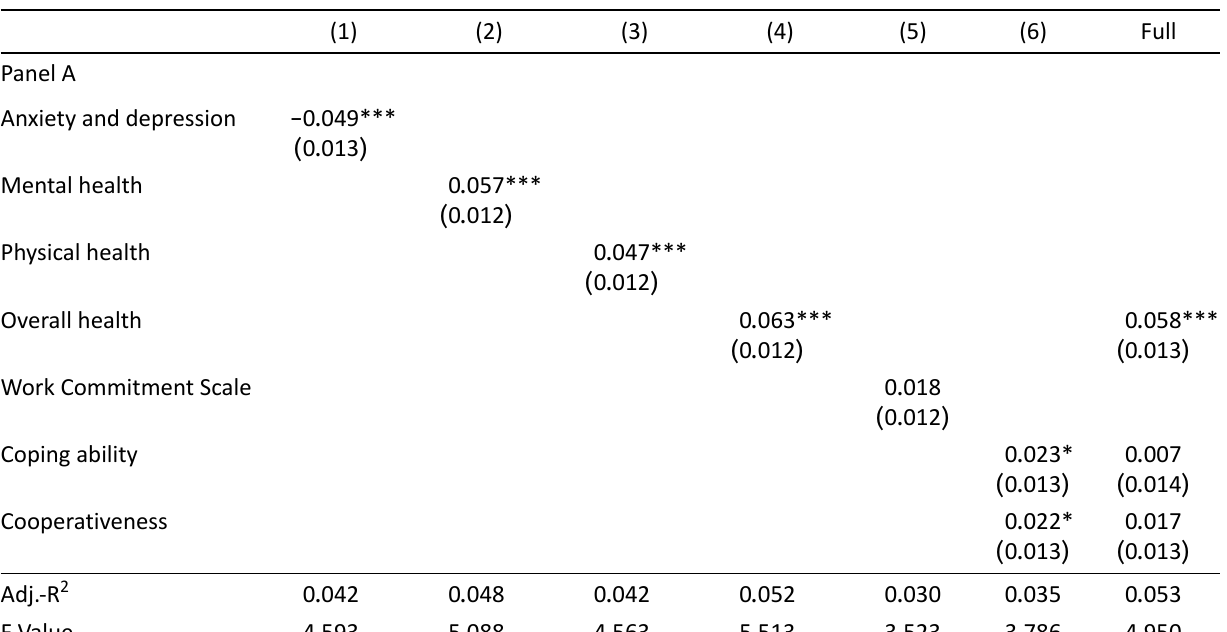
Table 2. Finding a first job without employment